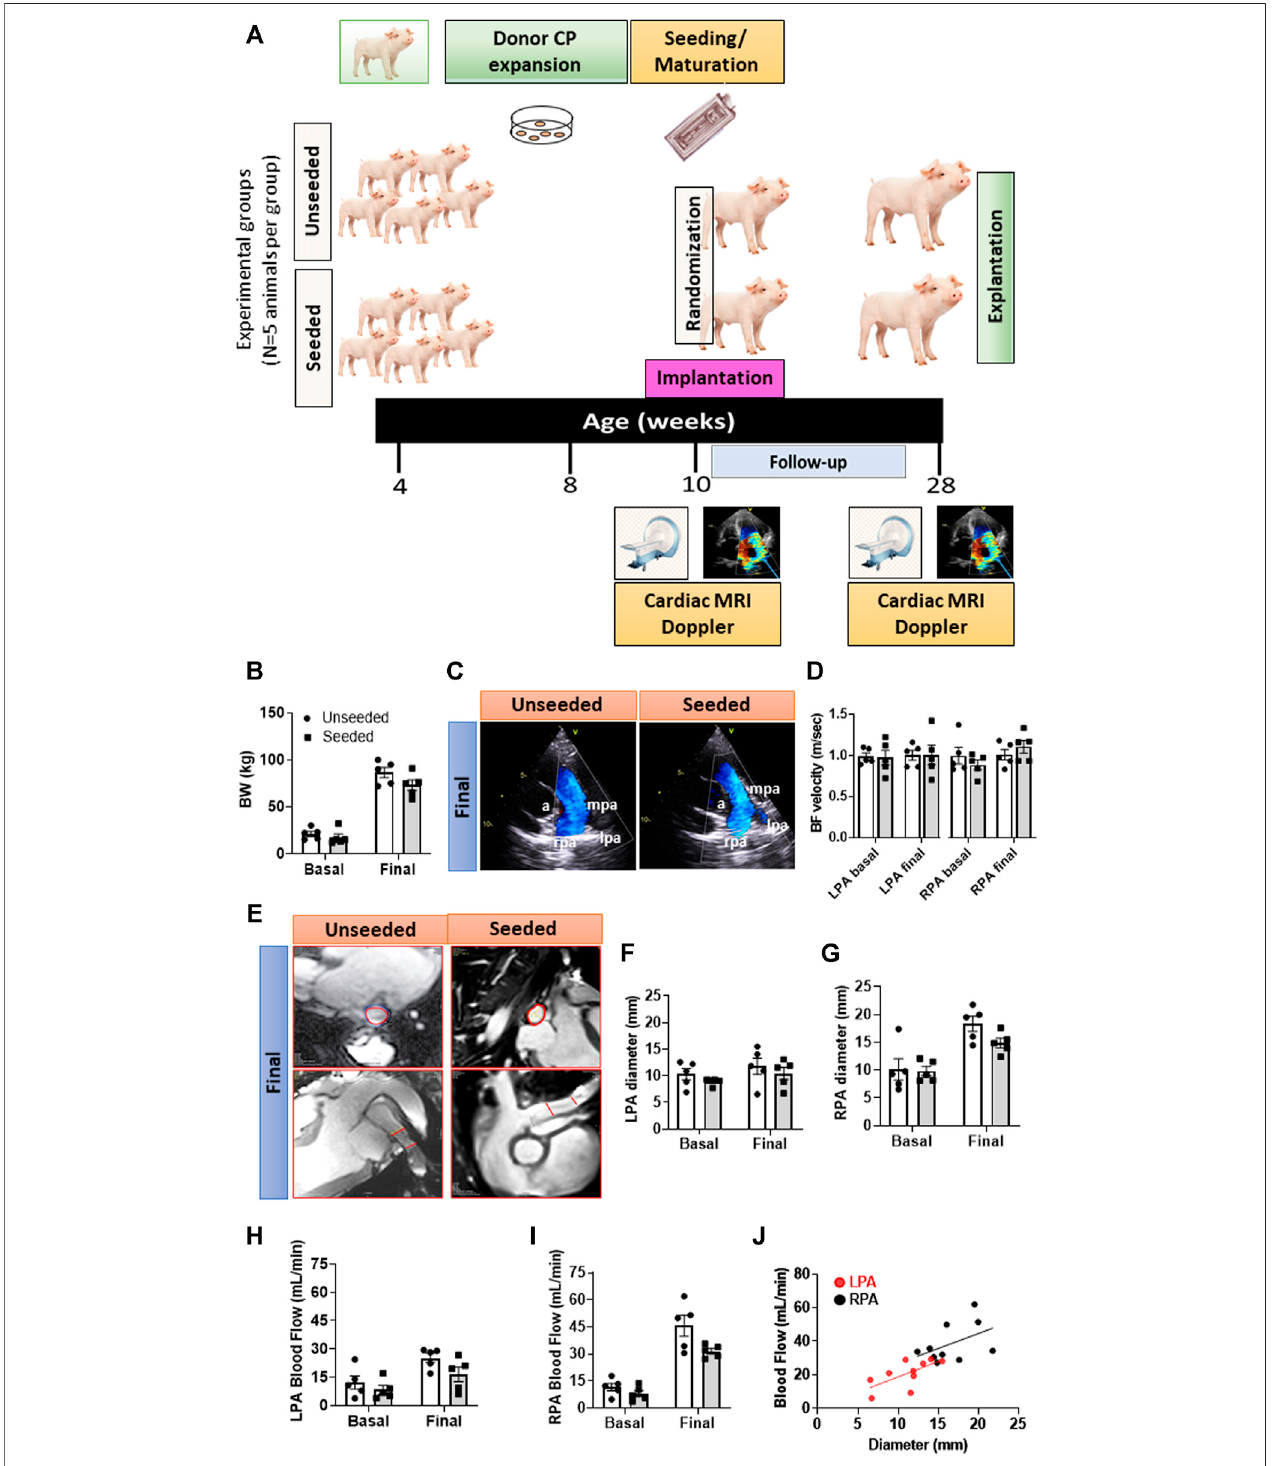
FIGURE 1 | General outcome and imaging endpoints of the randomized, controlled preclinical study. (A) Schematic of the study. (B) Body weight of animals randomizedtothetwogroups. (C) RepresentativeimagesofDopplerechocardiography.Vascularstructuresarehighlightedintheimages:a (cid:1) aorta,lpa (cid:1) leftpulmonary artery,mpa (cid:1) mainpulmonaryartery,rpa (cid:1) rightpulmonaryartery. (D) ColumngraphandindividualDopplerdatainthetwogroupsatbaselineand4-mothsfollow-up. (E) Representative images of the cardiac MRI showing transversal and longitudinal sections of the site of grant implantation delimited by the red lines. (F – I) Column graph and individual MRI data (diameter and blood fl ow) in the two groups at baseline and 4-months follow-up regarding the LPA (F,H) and RPA (G,I) . (J) Correlation between diameter and blood fl ow regarding LPA and RPA. Abbreviations: BF (cid:1) blood fl ow, BW (cid:1) body weight. N (cid:1) 5 biological replicates per experimental group. Data are expressed as mean ±